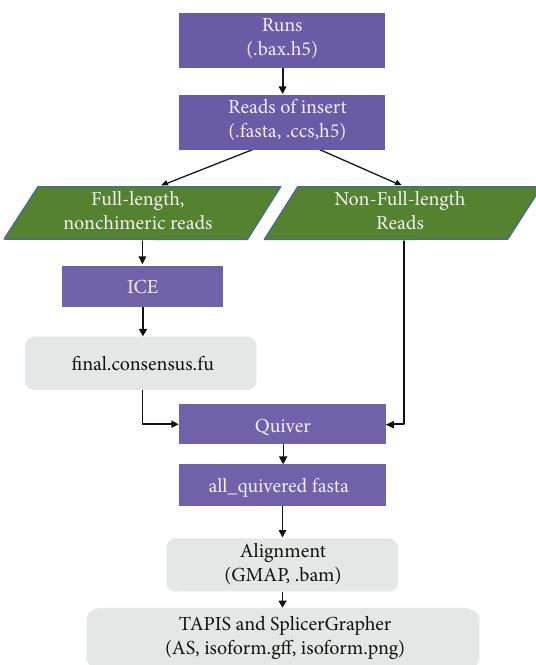
Figure 1: The analysis work fl ow of Iso-Seq